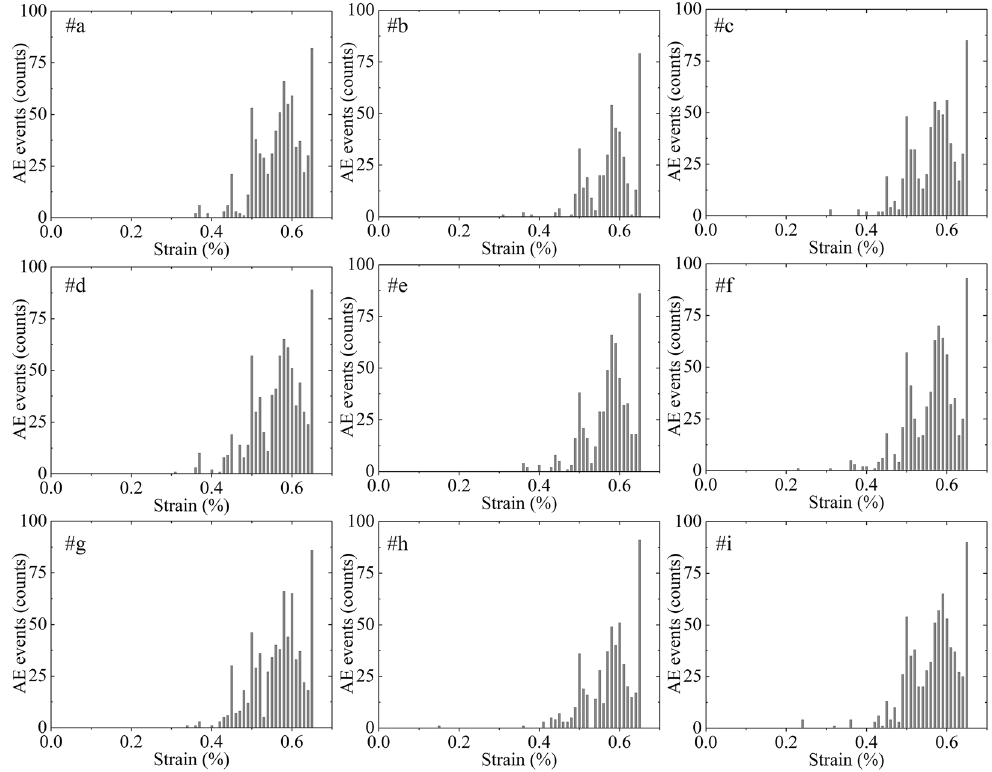
Figure 8. The number of simulated AE events at AE sensors #a ~ #i versus axial strain by